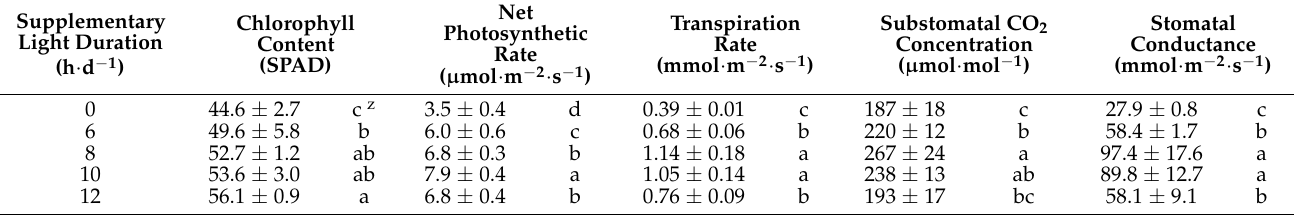
Table 1. Photosynthetic characteristics of cucumber seedlings grown in the greenhouse for 21 days after sowing as affected by supplementary light-emitting-diodes with light duration at 0, 6, 8, 10, and 12 h d − 1 with the same daily light integral. Supplementary Light